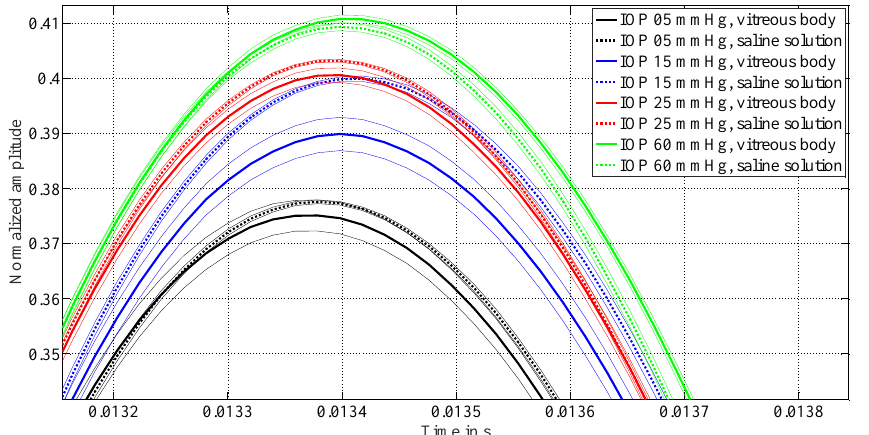
Figure 3. Allocation of curves measured from eyes with vitreous body and measurements after vitrectomy with 0.9% saline solution as replacement for the vitreous body. A similar ascending order of the individual IOP response proves that the principle works on eyes with the vitreous body in place. Except for 15mmHg amplitude, heights only change by 0.3% with respect to the excitation pulse. The frequency changes by 1.5 to